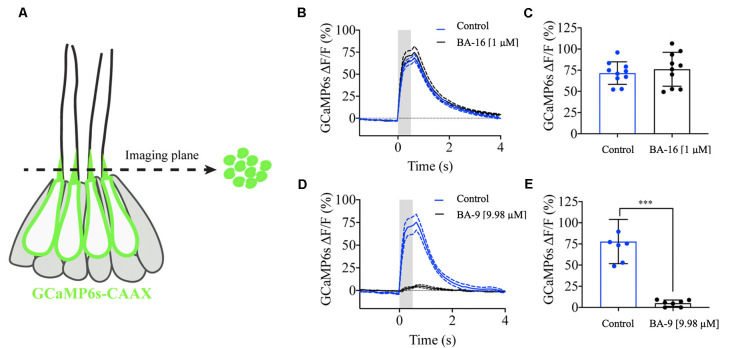
Berbamine analogs differentially reduce mechanotransduction channel activity. Mechanosensitive-calcium signals from hair bundles of posterior lateral line neuromasts. (A) Side view of a neuromast expressing hair cell-specific membrane-localized GCaMP6s. Left: an imaging plane through the apical hair bundles can be used to measure mechanosensitive-calcium signals during fluid-jet stimulation. Right: a top-down view of the imaging plane showing the hair bundles expressing GCaMP6s. (B) Traces comparing the average GCaMP6s signals before and after application of 1 μM BA-16, N = 10 neuromasts. (C) Dot plots quantifying the peak GCaMP6s response per neuromast. BA-16 does not alter evoked calcium activity in hair cells. (D) Traces comparing the average GCaMP6s signals before and after application of 1 μM BA-9, N = 7 neuromasts. (E) Dot plots quantifying the peak GCaMP6s response per neuromast. BA-9 reduces MET-evoked calcium activity compared to baseline levels. Each dot in (C,E) averages the response of all hair bundles in each neuromast. A paired t-test was used in (C,E), ***p < 0.001. Error bars in (C,E) and dashed lines on either side of the solid line in (B,D) represent ± SEM.